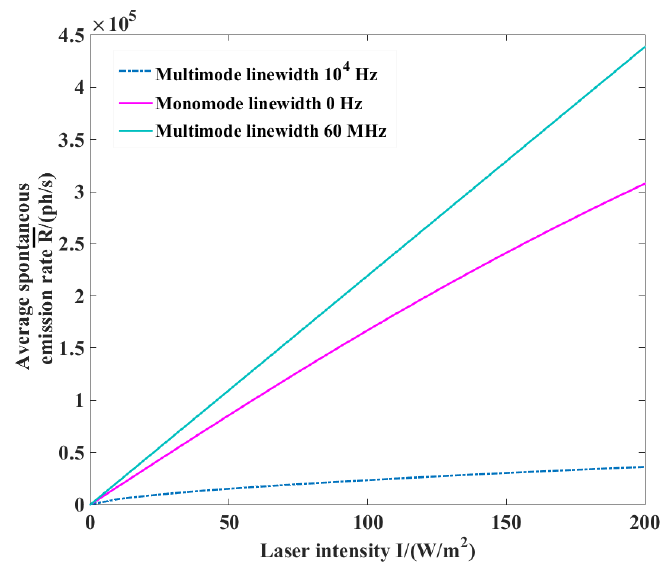
Figure 15. Average spontaneous emission rates vs. intensity at linewidth 0, 1, 0.01